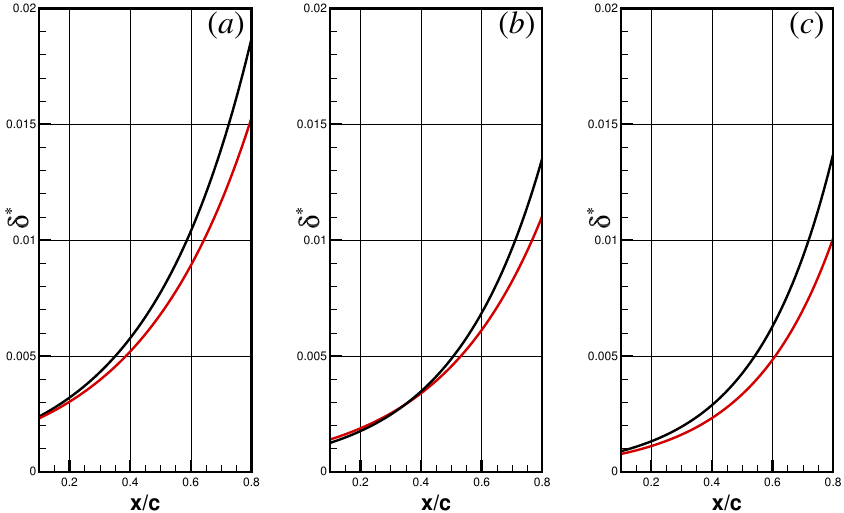
Figure 7. Effect of riblets on the displacement thickness on the airfoil suction side [35]. ( a ): NACA 0015, Re L = 180,000, α = 10 ◦ ; ( b ): NACA 0012, Re L = 300,000, α = 8 ◦ ; ( c ): EPPLER 387, Re L = 300,000, α = 7 ◦